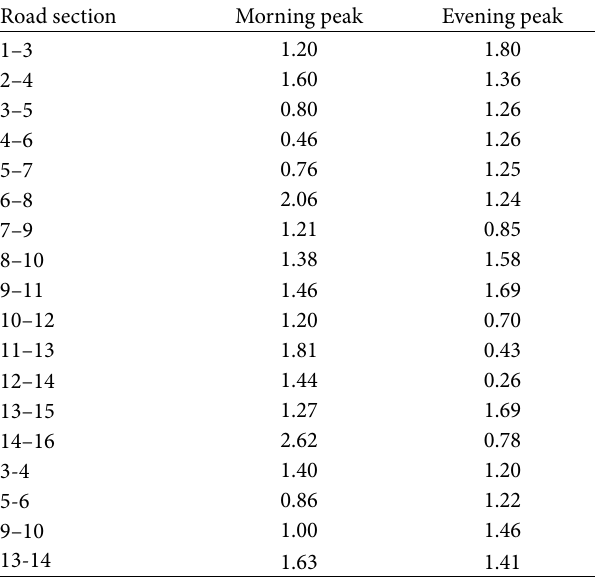
Figure 4: One-way traffic management